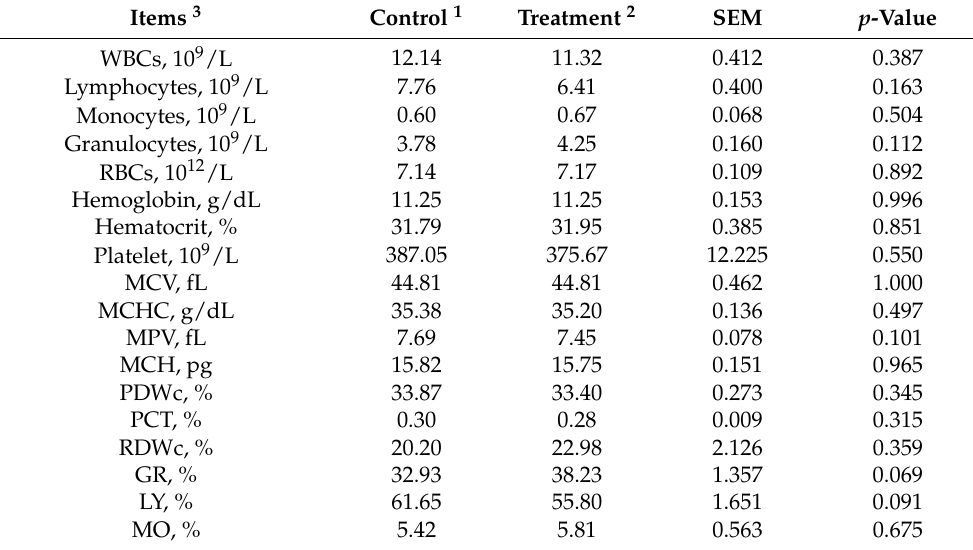
Table 8. Effects of noni meal on complete blood cell counts in Holstein dairy